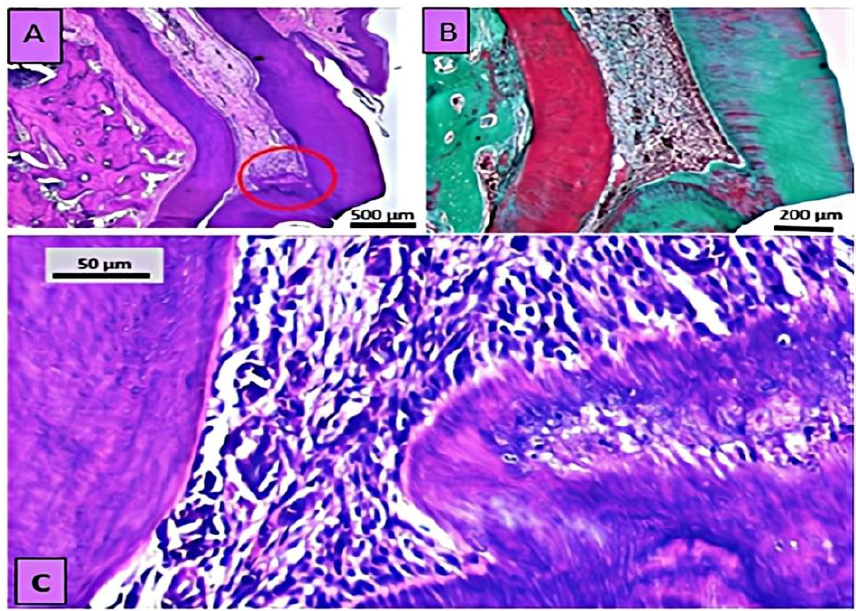
Figure 4. ( A – C ) (4×, 10×, and 40×): Microscopic view of occlusal restoration with nano-HA-SiO 2 -GIC showing Grade 1 inflammation at 1 month of sacrifice in the area encircled as red in ( A ) (( A , C ) = H&E stain, ( B ) = trichrome stain).